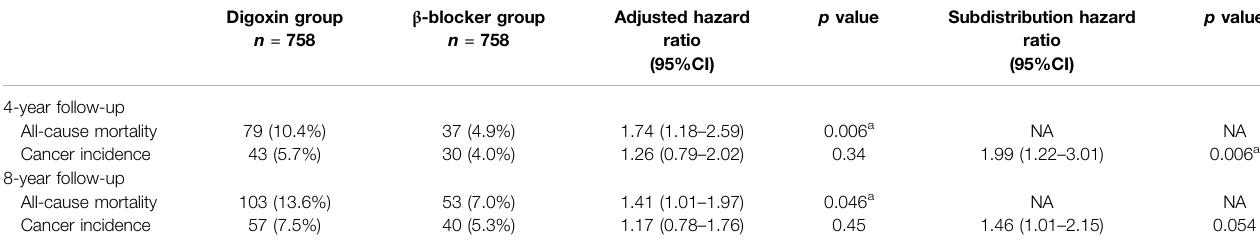
TABLE 2 | All-cause Mortality and Cancer incidence Between Two Groups After 1:1 propensity score-matching. Digoxin group n = 758